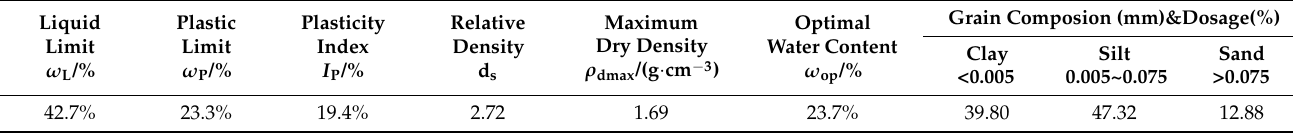
Table 2. Physical properties of soil specimen.